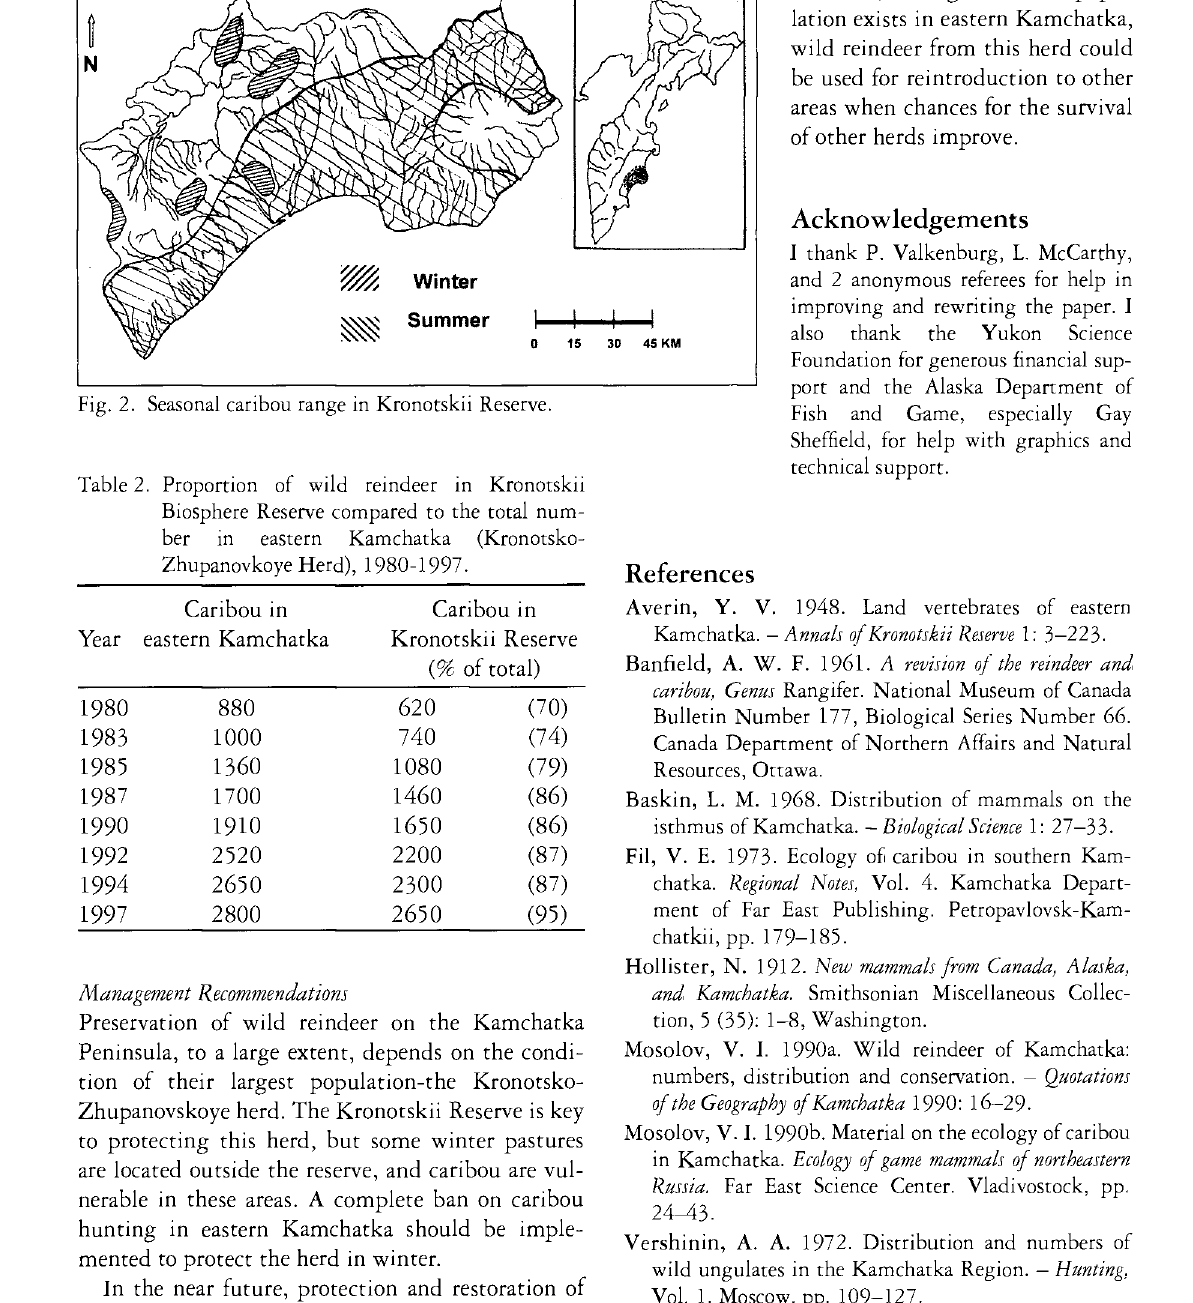
Fig. 2. Seasonal caribou range in Kronotskii Reserve.